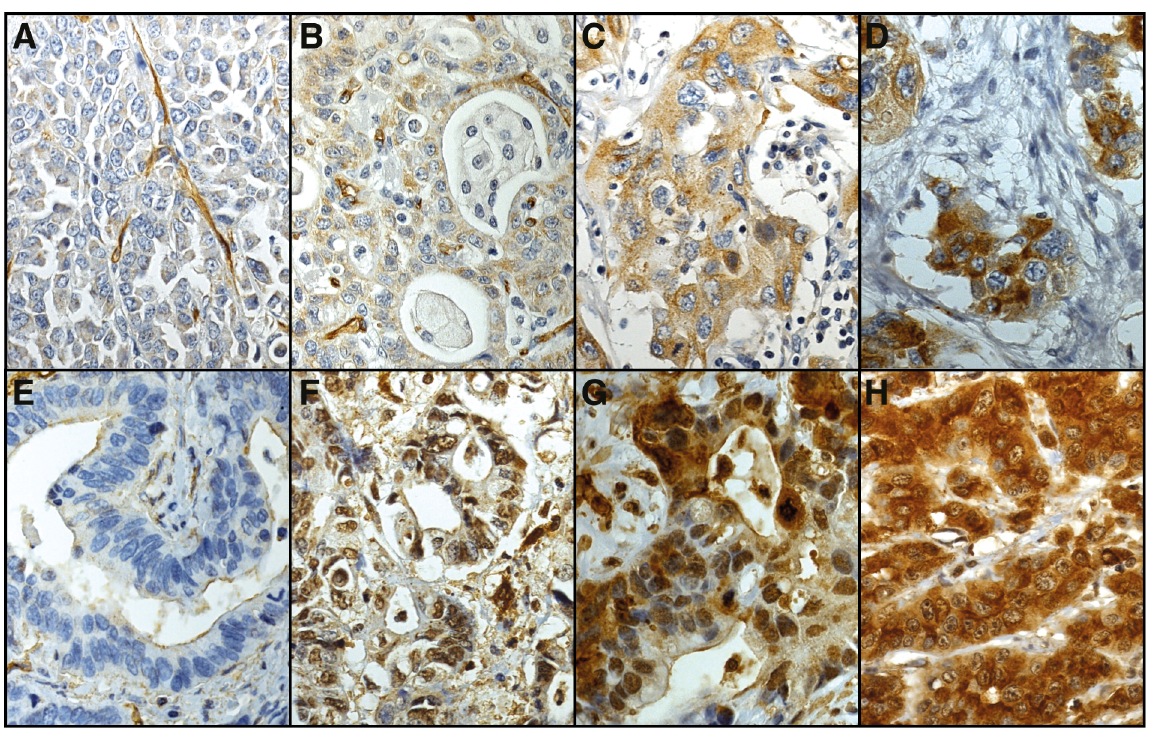
Fig 1. Representative images of HPA2110 and HES9 staining representing gastric cancer tumors with negative (A, E), weak (B, F), moderate (C, G), and strong (D, H) staining in a varying proportion of tumor cells. Images A-D stained with the polyclonal HPA2110 antibody and E-H with the monoclonal HES9 antibody. Original magnification